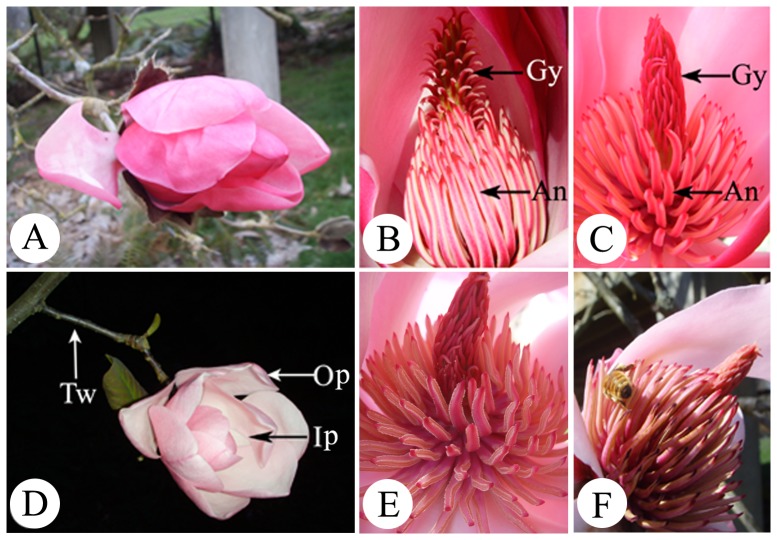
Morphology of an individual flower of Magnolia sprengeri at the pre-pistillate (A), pistillate (B), pre-staminate (C, D), staminate (E) and post-staminate (F) stages.(A) Pre-pistillate stage: petals folded tightly with pistils opened. (B) Pistillate stage: functionally female flowers with receptive stigmas and immature stamens with no dehiscent anthers. (C) and (D) Pre-staminate stage: a floral chamber with appressed and unreceptive stigmas and non-dehiscent anthers. (E) Staminate stage: functionally male flowers with gynoecium starting to fade; stamens detached from the axis and the anthers dehisced. (F) Post-staminate stage: withered flowers with the petals and stamens becoming brown and abscised; the stigma withered. Abbreviations: An, androecium; Gy, gynoecium; Ip, inner petals; Op, outer petals; Tw, twig.